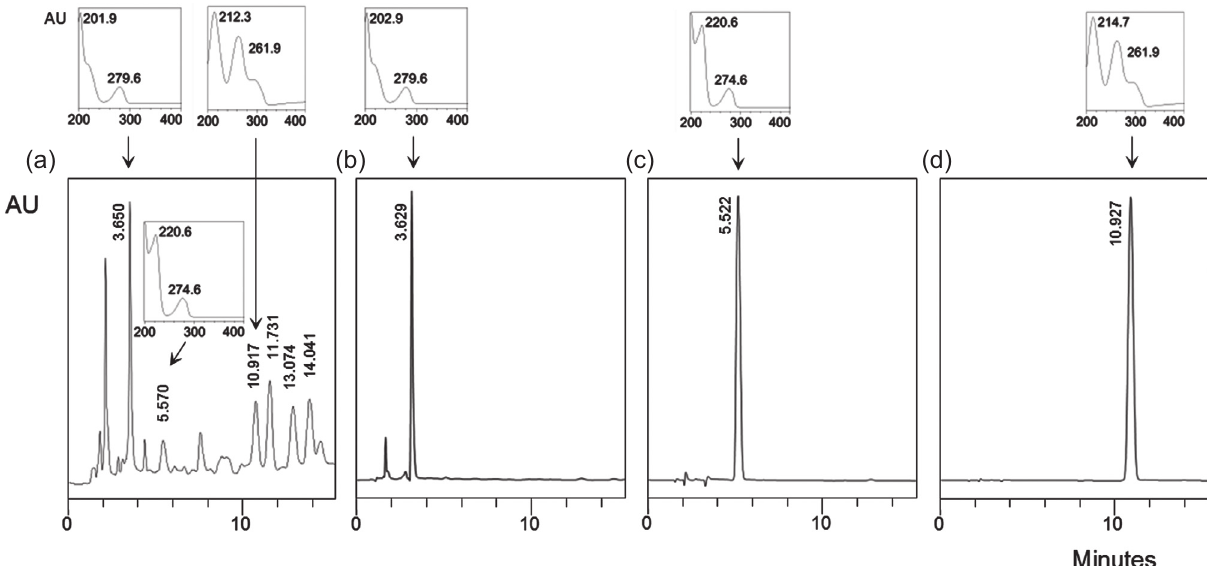
Figure 2. Chromatography . HPLC chromatograms and peak spectra of (a) an olive ethanolic extract (OEE; from Olea europaea L. fruit pomace; 260 nm) and pure reference compounds which could be confirmed as constituents of the extract, (b) hydroxytyrosol (280 nm), (c) tyrosol (280 nm) and (d) trans- coniferyl alcohol (260 nm). Retention times (minutes; rotated view), the relative absorption intensity (AU) and UV spectra together with absorption maxima (wavelengths in nm) are